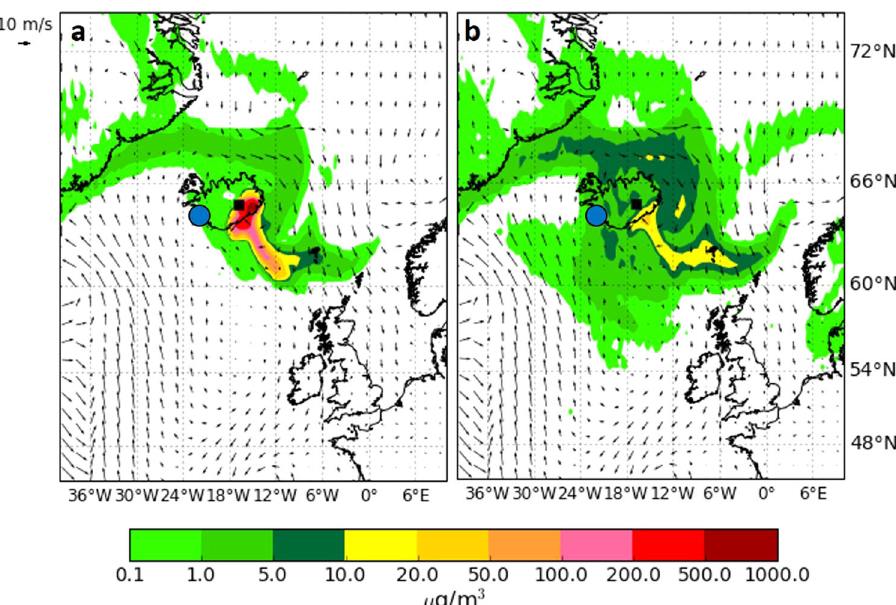
Fig. 1 Dispersion of primitive and mature plumes. The ground-level concentrations of ( a ) SO 2 and ( b ) SO 4 2 − (units: µ g/m 3 ) from Holuhraun eruption, simulated for 20 September 2014. Wind vectors (black arrows) are used to show the plume transport direction. Black square: eruption site. Blue circle: Reykjavík (area approximate). The primitive plume (high mass ratio of SO 2 to SO 4 2 − ) is dispersed predominantly to the south-east of the eruption site. The mature plume (high mass ratio of SO 4 2 − to SO 2 ) has returned back from Europe and is inundating the Reykjavík capital area from the south. Figure is modi fi ed from Ilyinskaya et al. 10 . See Supplementary Movie 1 for